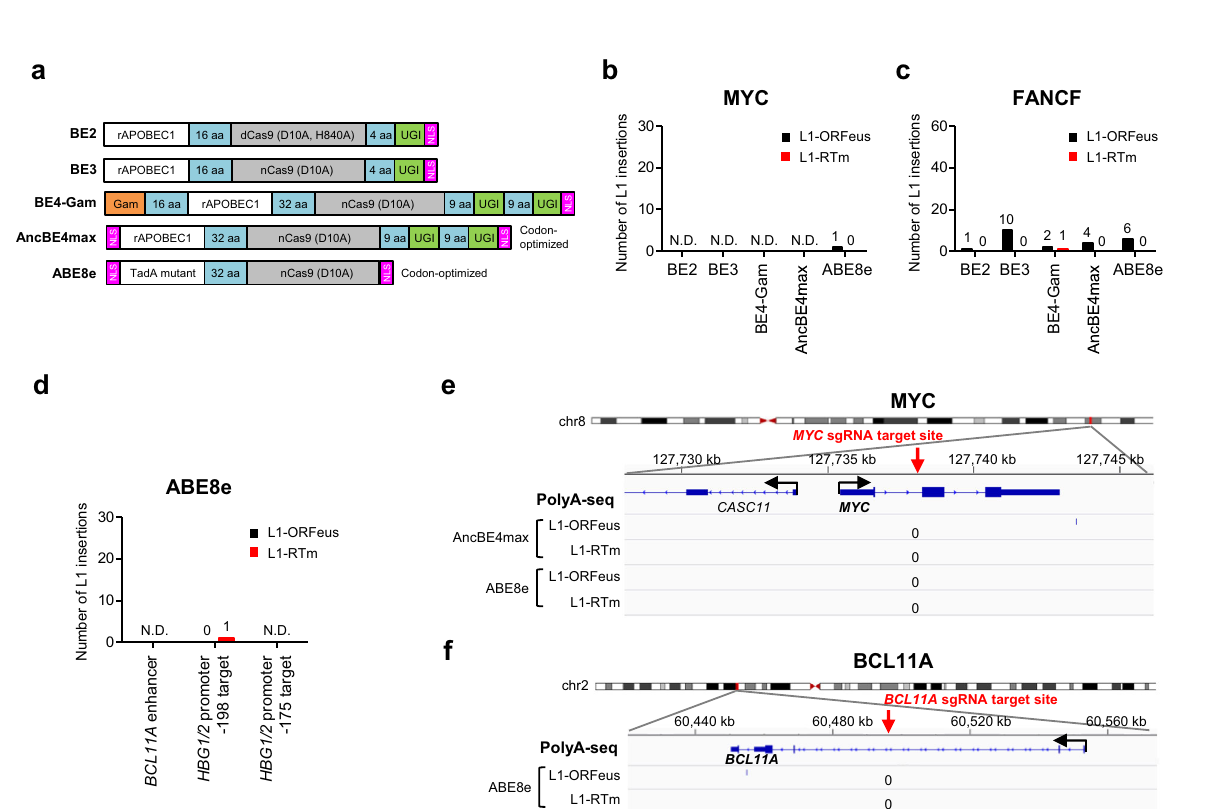
Fig. 8 De novo L1-ORFeus insertions are rare in base editing. a Diagram of the base editors. BE2, BE3, BE4-Gam, and AncBE4max are developed as cytosine base editors (CBEs), while ABE8e is an adenine base editor (ABE). b , c Numbers of L1-ORFeus insertions obtained by amplicon sequencing at the MYC ( b ) or FANCF ( c ) base editing site targeted by BE2, BE3, BE4-Gam, AncBE4max, or ABE8e in HEK293T cells expressing L1-ORFeus or L1-RTm. d Numbers of L1-ORFeus insertions obtained by amplicon sequencing at the BCL11A enhancer or HBG1/2 promoter ( − 198 bp/ − 175 bp target) base editing site targeted by ABE8e in HEK293T cells expressing L1-ORFeus or L1-RTm. e Detailed view of the distribution of L1-ORFeus insertions at the MYC base editing site obtained by PolyA-seq in HEK293T cells targeted by AncBE4max or ABE8e that express L1-ORFeus or L1-RTm. f Detailed view of the distribution of L1-ORFeus insertions at the BCL11A enhancer base editing site obtained by PolyA-seq in HEK293T cells targeted by ABE8e that express L1- ORFeus or